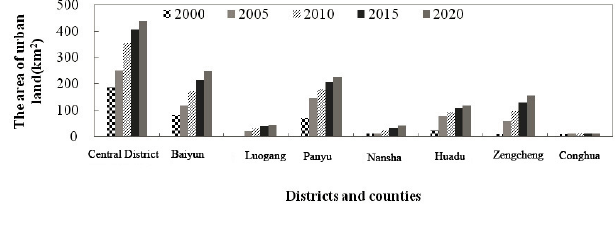
Fig. 3 . The urban land in the Guangzhou metropolitan region in 2000~2020 (km²).